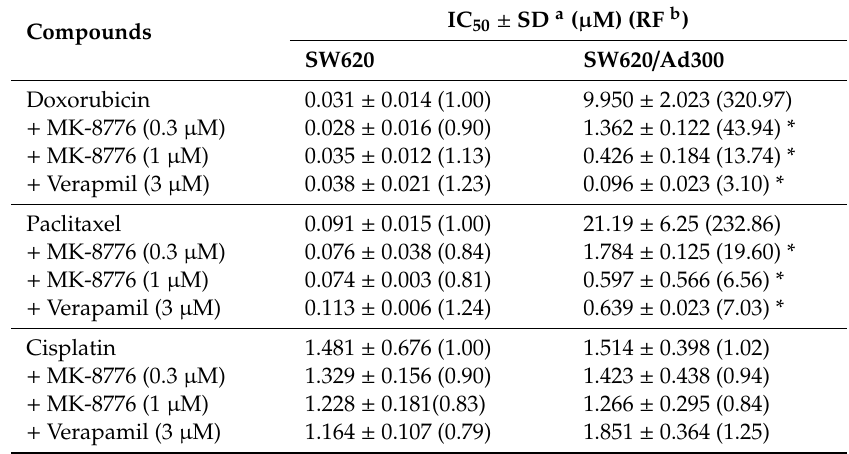
Table 2. MK-8776-sensitized doxorubicin and paclitaxel in SW620 / Ad300 cells.